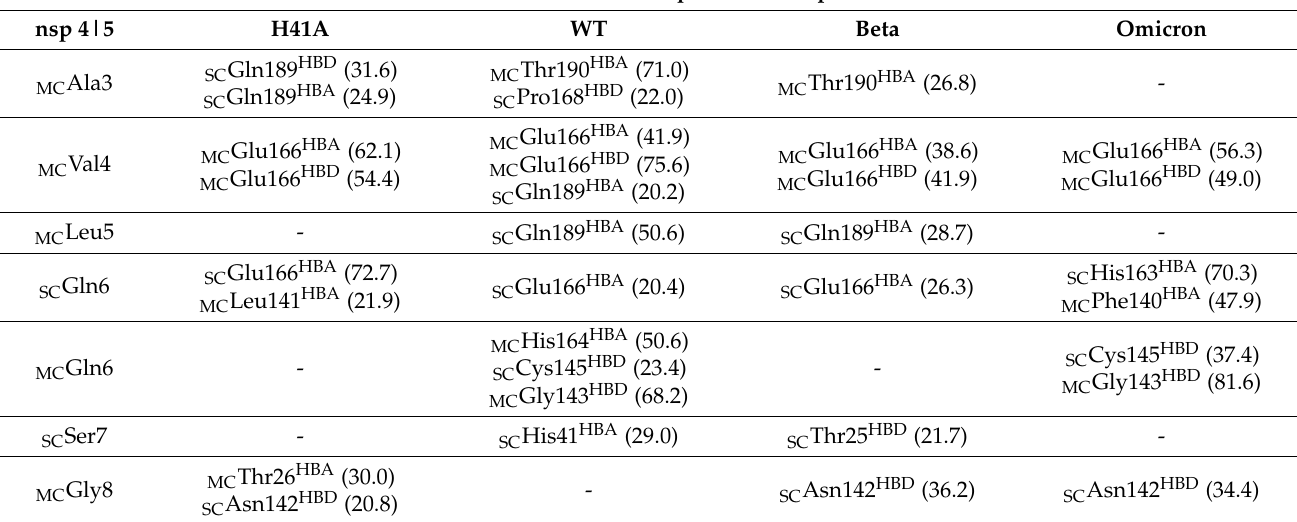
Table 4. Hydrogen bonding occupancies of substrate nsp 4|5 interacting with 3CLpro variants. The hydrogen bonding occupancies considered relevant were at least 20%. Note that MC = main chain; SC = side chain; HBA = hydrogen bonding acceptor; HBD = hydrogen bonding receptor.